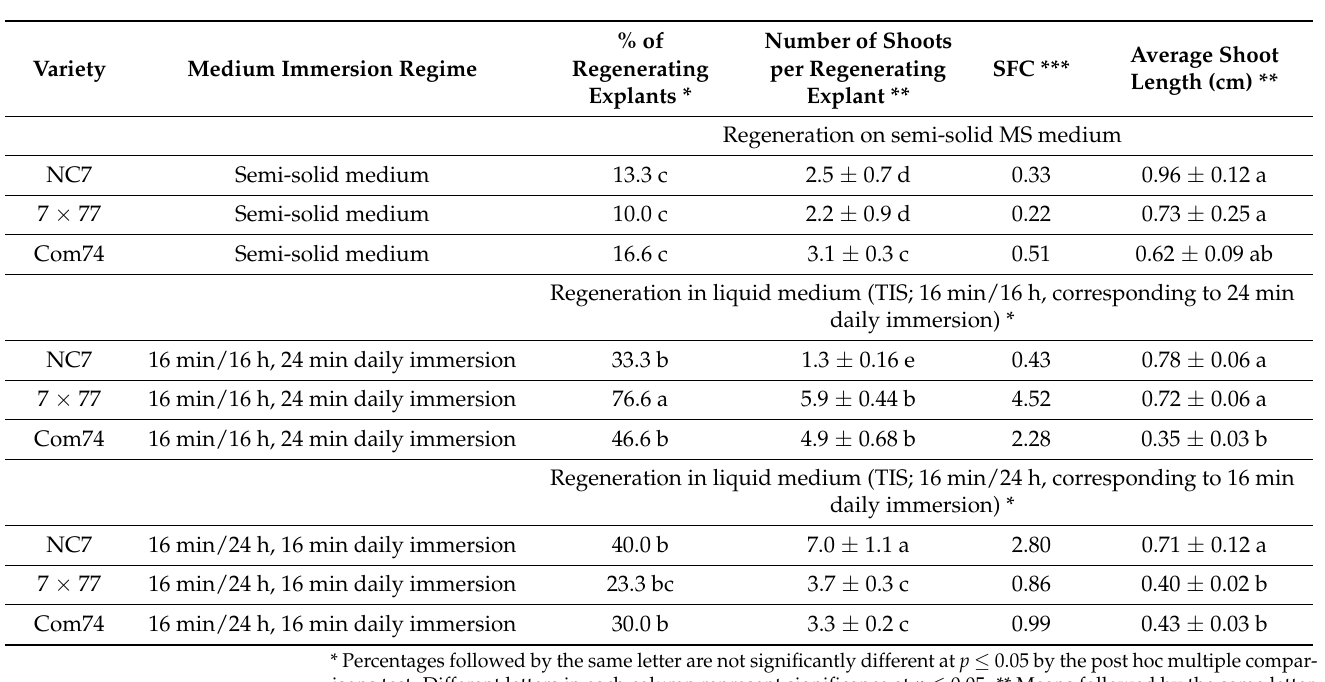
Table 5. De novo regeneration of Arachis hypogaea L. varieties, NC7, 7 × 77, and Com74, from